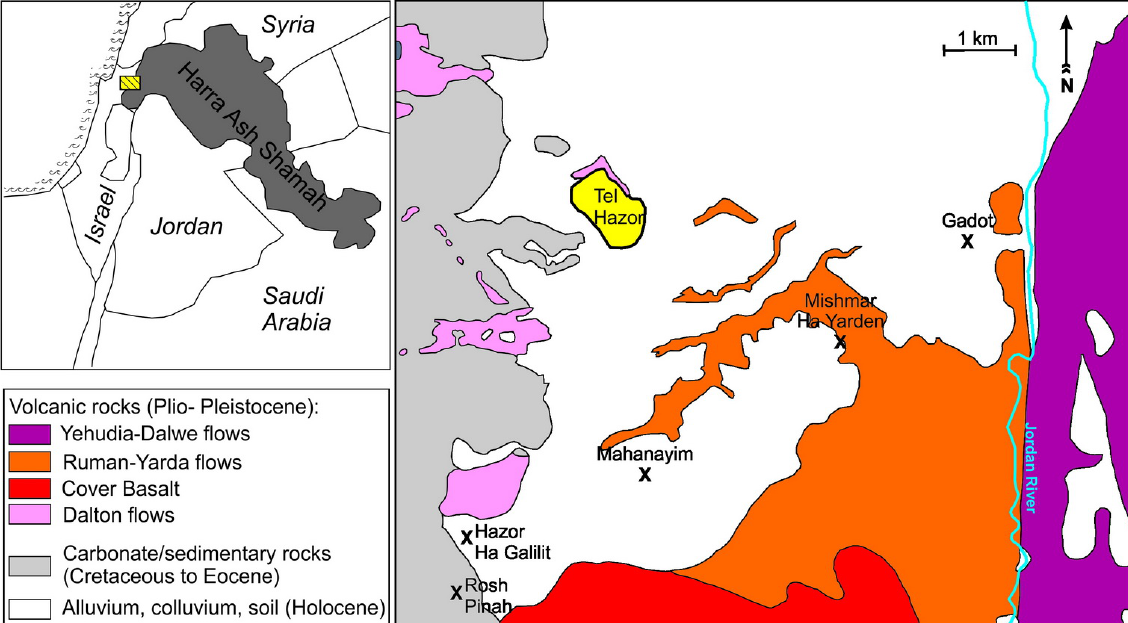
Figure 1: The geological situation of Tel Hazor in the southern Hula basin. Detail of the Rosh Pinah geological map (Sneh & Weinberger